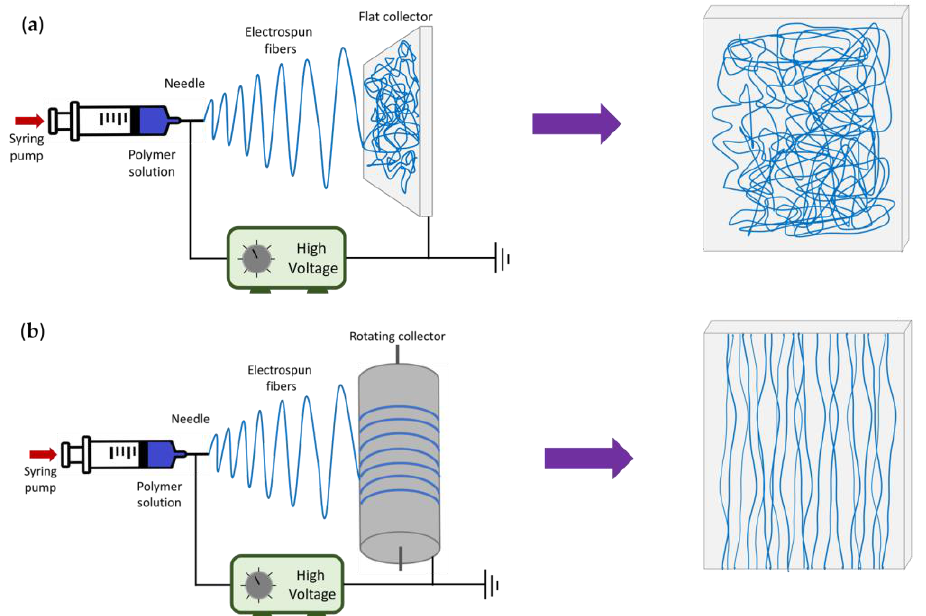
Figure 1. Schematic representation of the electrospinning setup and the final distribution of the fibers in each type of collector. ( a ) Flat collector and ( b ) rotating collector.